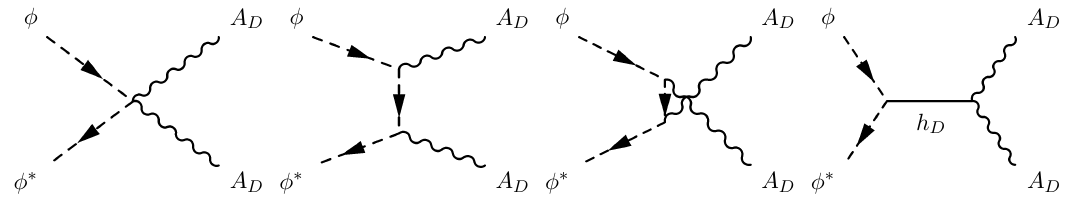
∗ φ → A D A D amplitude at tree level.